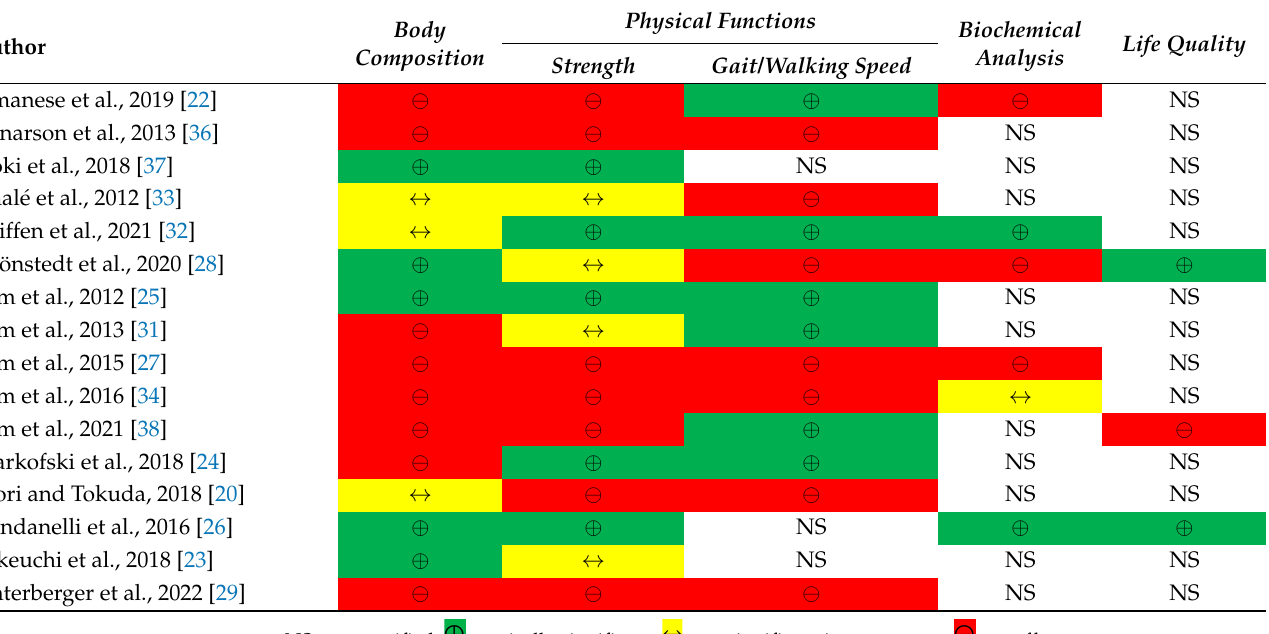
Table 3. Summary of the primary and secondary outcomes associated with exercise training and supplementation in elderly